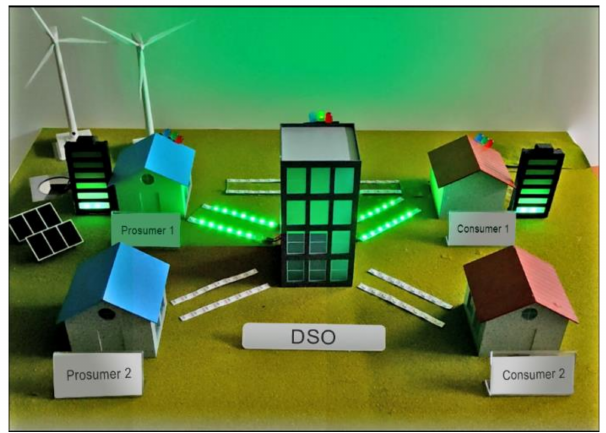
Figure 14. Testbed for